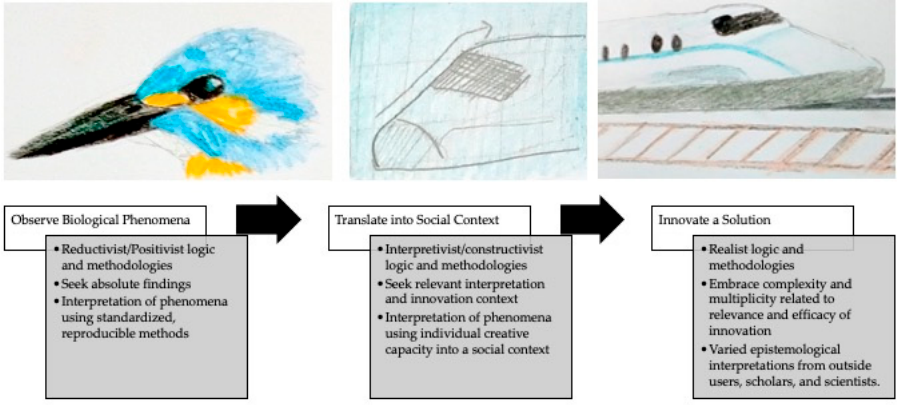
Figure 2. The epistemological shift of bioinspired innovation (BII).